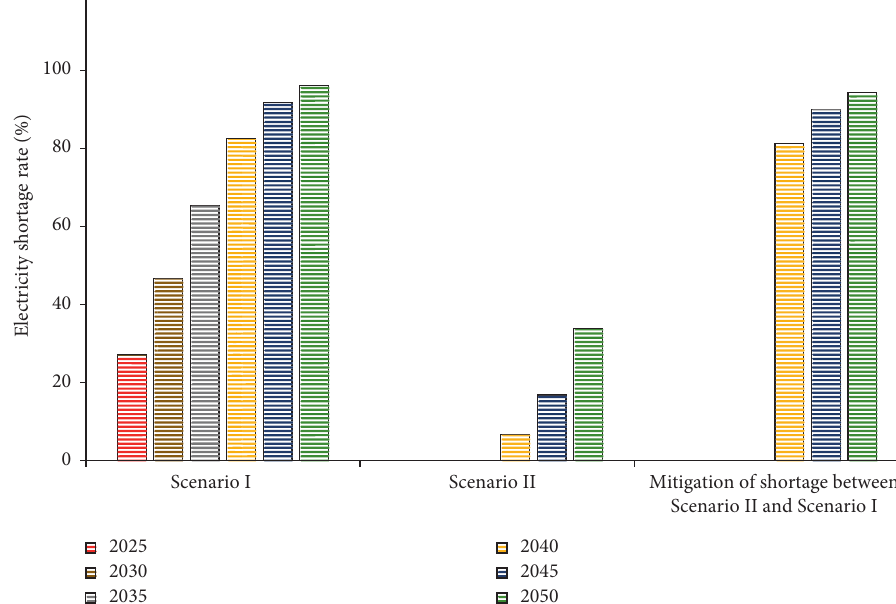
Figure 4: Increase in electricity shortage rate and mitigation between Scenarios I and